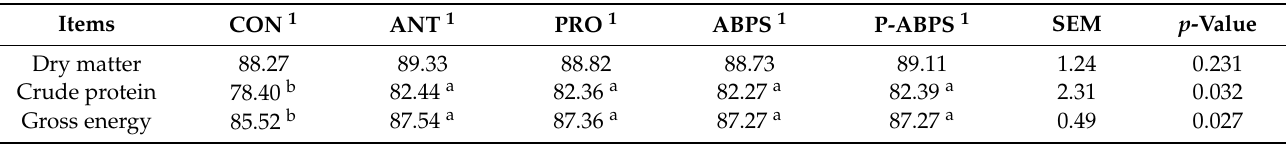
Table 3. Effects of probiotics and Achyranthes bidentata polysaccharides on apparent total tract digestibility (ATTD) of diet fed to piglets.